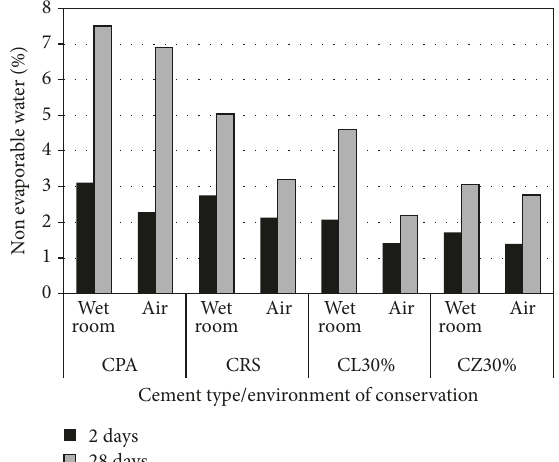
Figure 13: Nonevaporable water in relation to curing medium for types of